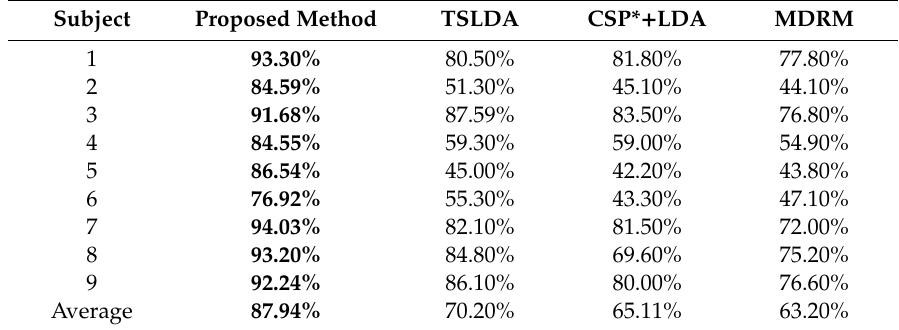
Table 4. Comparison of cross-validation classification results (in %) with other related approaches for the 2a multiclass dataset obtained from the BCI competition